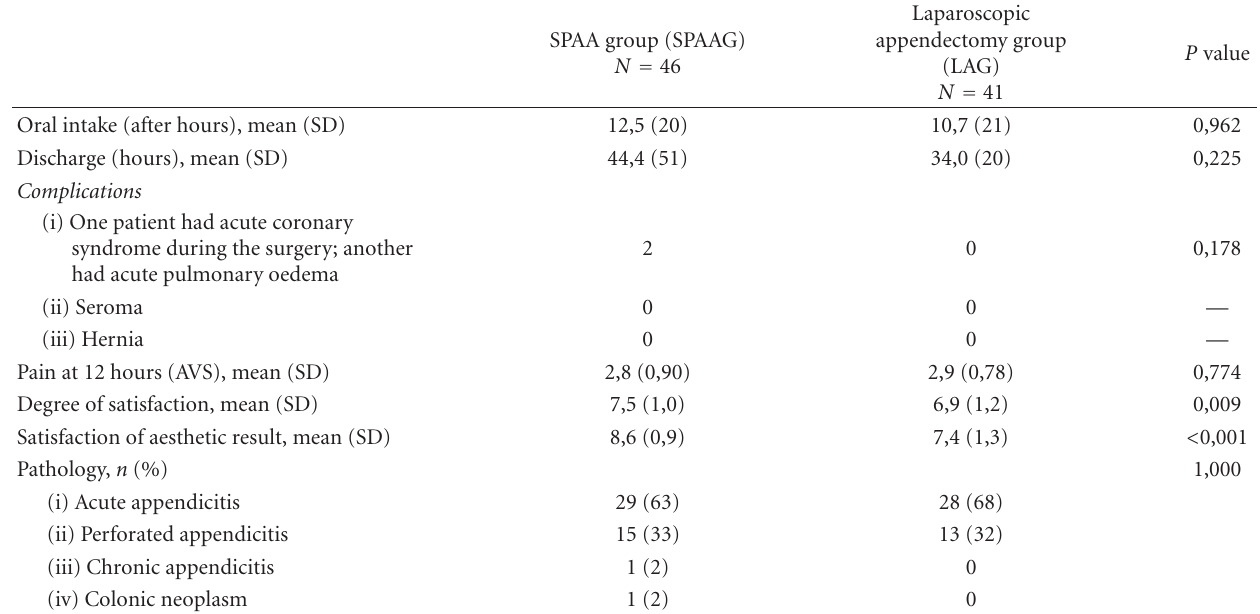
Table 3: Postoperative results and